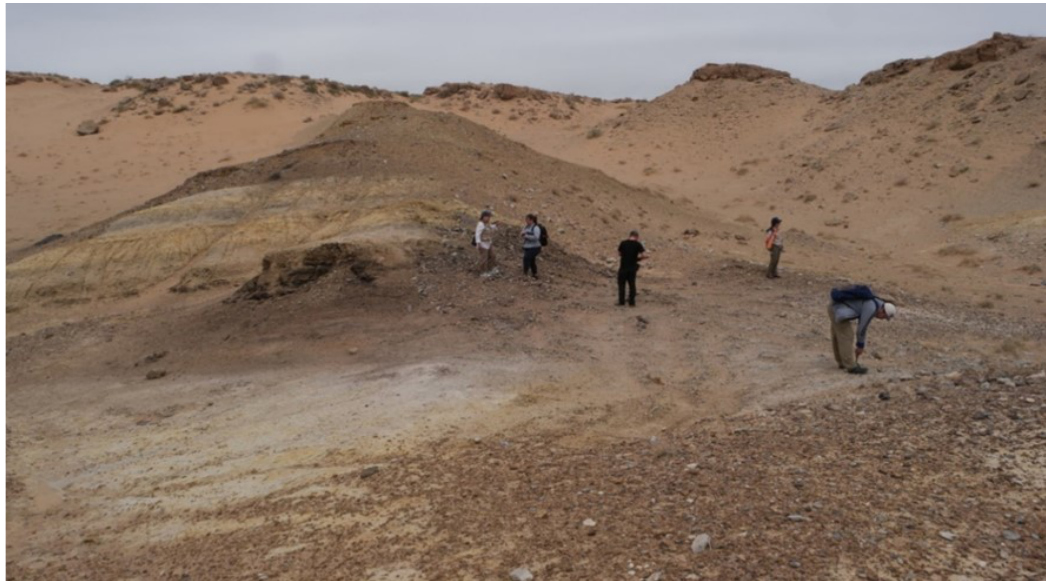
Fig. 5. Outcrop of Mid Coal-bearing